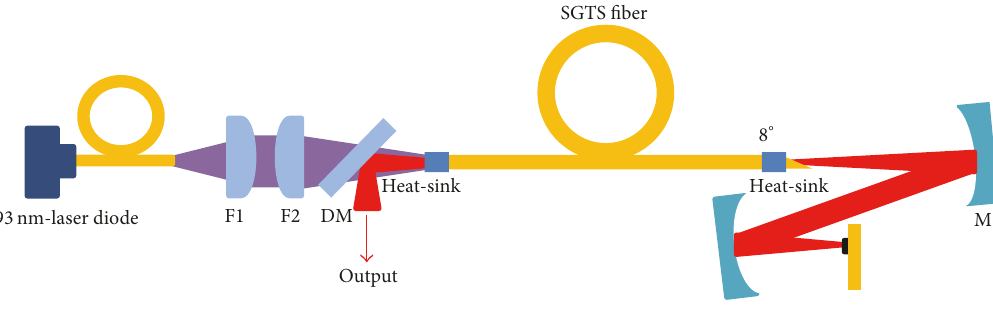
Figure 2: Experimental setup schematic of the BP Q-switched LMA Tm-doped fiber laser. DM: dichroic mirror; LMA TDF: large-mode-area Tm-doped fiber; BP SAM: black phosphorus saturable absorber mirror.